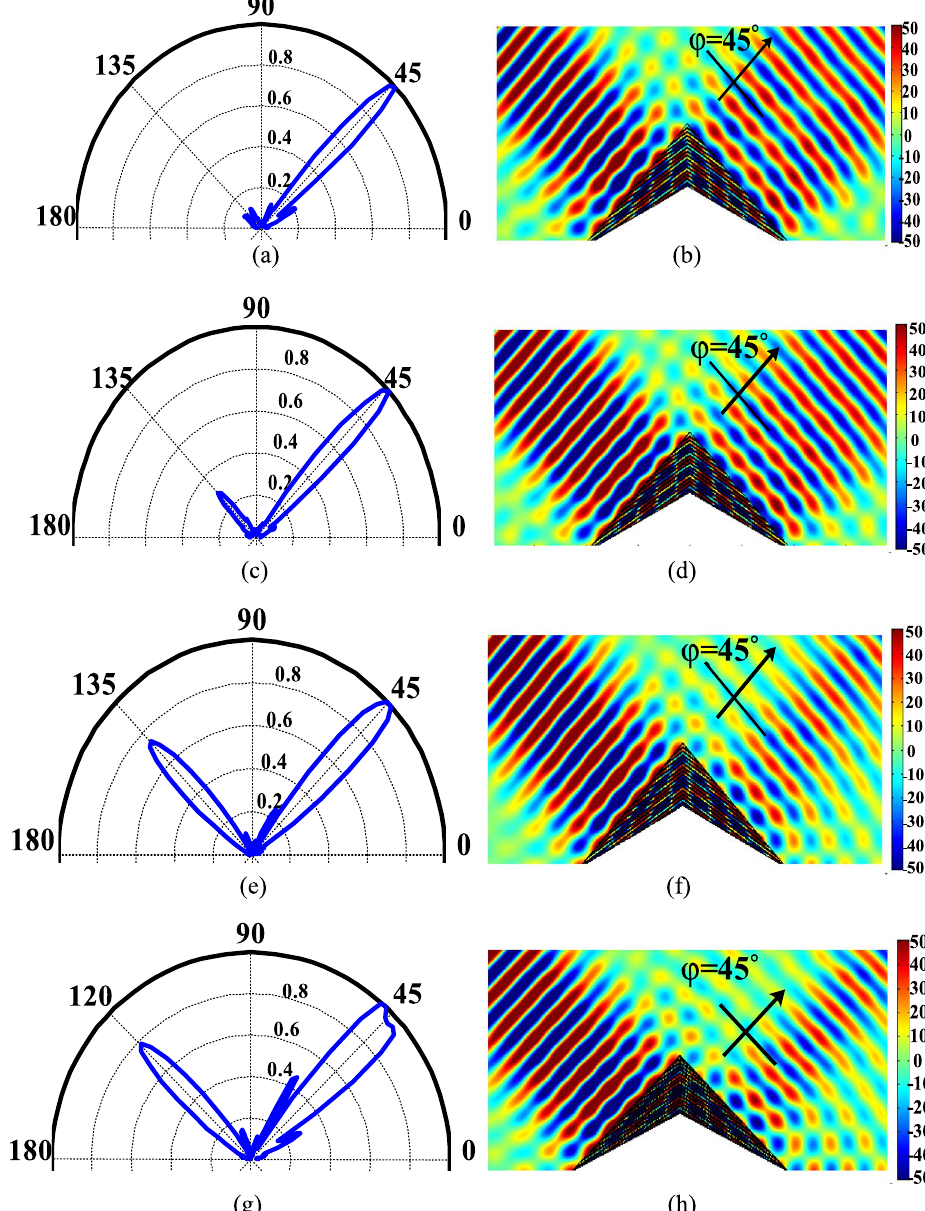
Figure 7. Numerically calculated far-field and near-field distribution of scattered fields for incident angle of ϕ = 135 ◦ at the wavelength of ( a , b ) (cid:31) = 532 nm , ( c , d ) (cid:31) = 533 nm , ( e , f ) (cid:31) = 535 nm and ( g , h ) (cid:31) = 536 nm